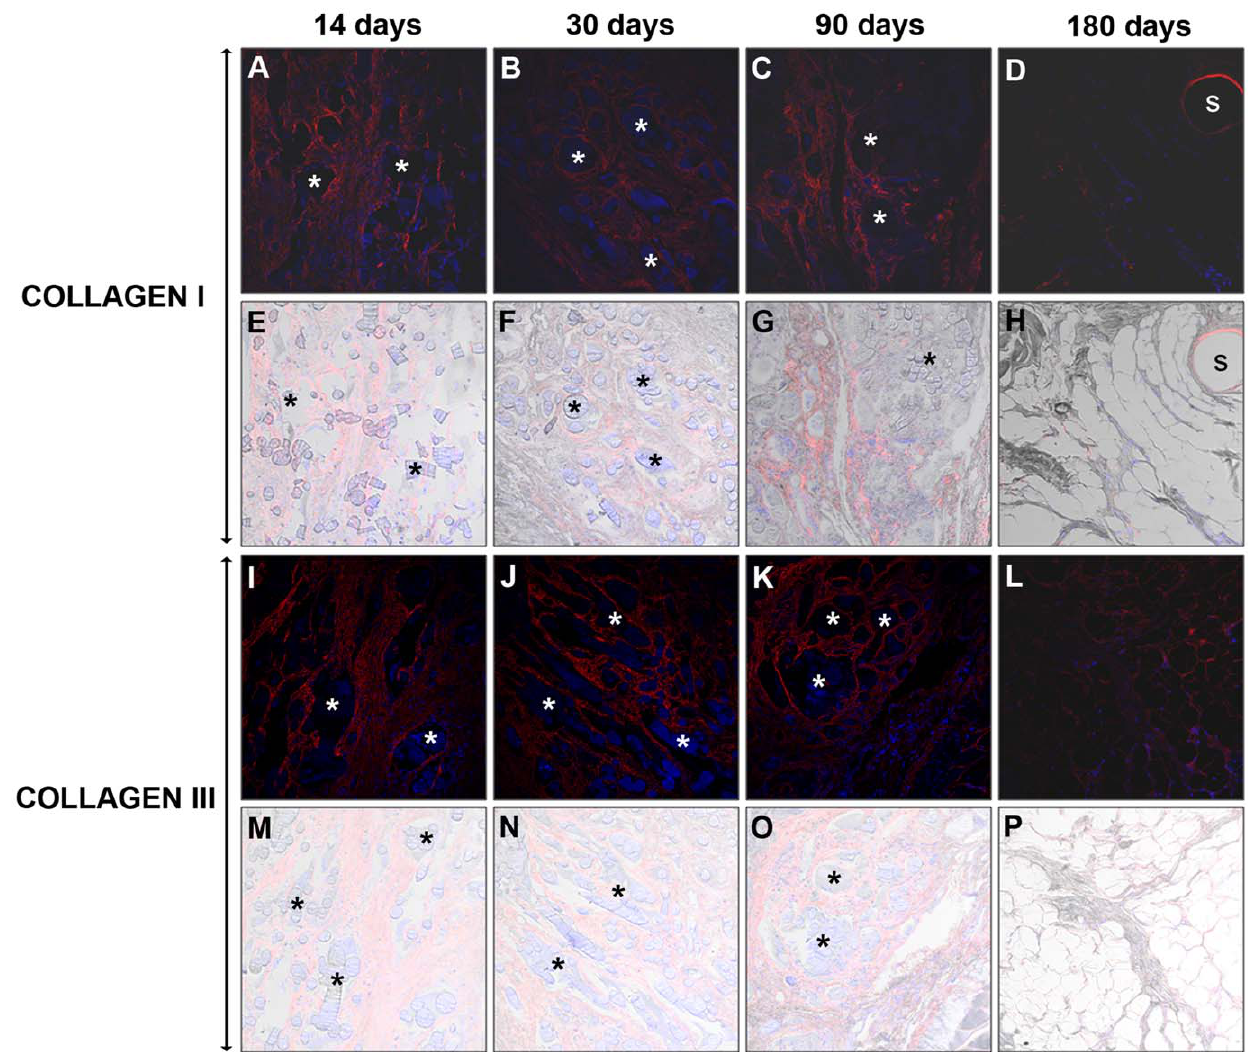
Figure 5. Immunodetection of neoformed collagen I and III in Bio-A H . Mature Collagen I (A–H) and immature Collagen III (I–P) immunofluorescence at 14, 30, 90 and 180 days post-implantation. The neoformed collagen appears in red and the cell nuclei (stained with DAPI) appear in blue. The DIC images that identify the biomaterial appear translucent (E–H and M–P). Confocal light microscopy (200 6 ). (* Synthetic mesh).